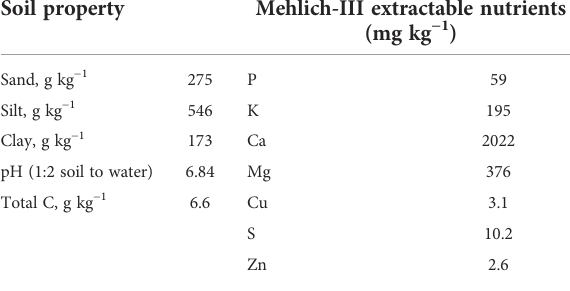
TABLE 1 Soil properties at the beginning of the experiment (Fall 2018).